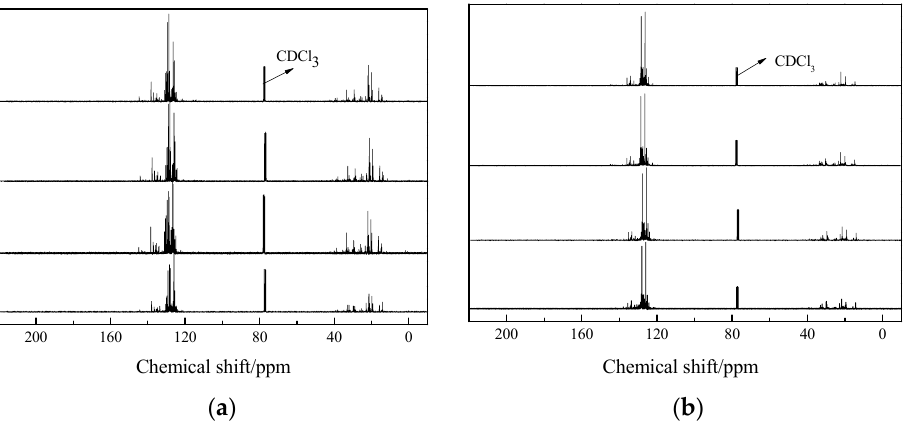
Figure 5. 13 C NMR curves of the liquid samples at different temperatures. ( a ) Diesel fraction; ( b ) heavy oil fraction.